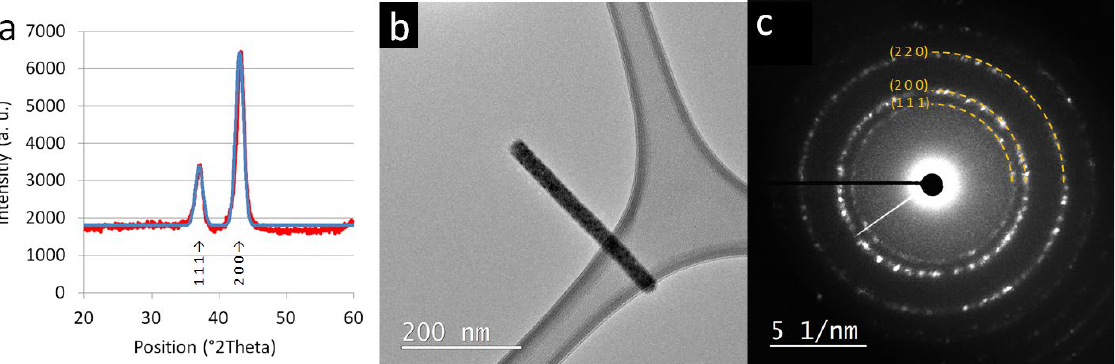
Figure 4. ( a ) (X-ray diffraction) XRD diffractogram of the TiON/C-CNF1 fabric (red) and a simulated XRD diffractogram of titanium oxynitride (TiON) nanoparticles (blue, 6 nm, based on the crystal structure Cambridge Crystallographic Data Centre (CCDC) 908784, N and O occupancy changed from N33 O67 to N365 O635), ( b ) transmission electron microscopy (TEM) image of a TiON/C-CNF2 segment (30 nm diameter), ( c ) selected area electron diffraction (SAED) pattern of the TiON/C - CNF2.